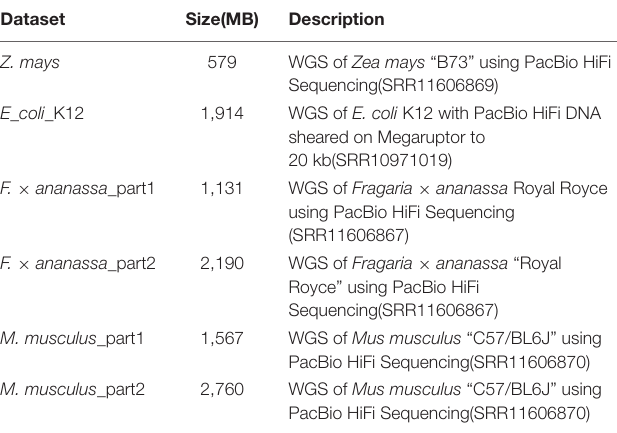
TABLE 1 | The PacBio-HiFi dataset used in the experiment and its description. Dataset